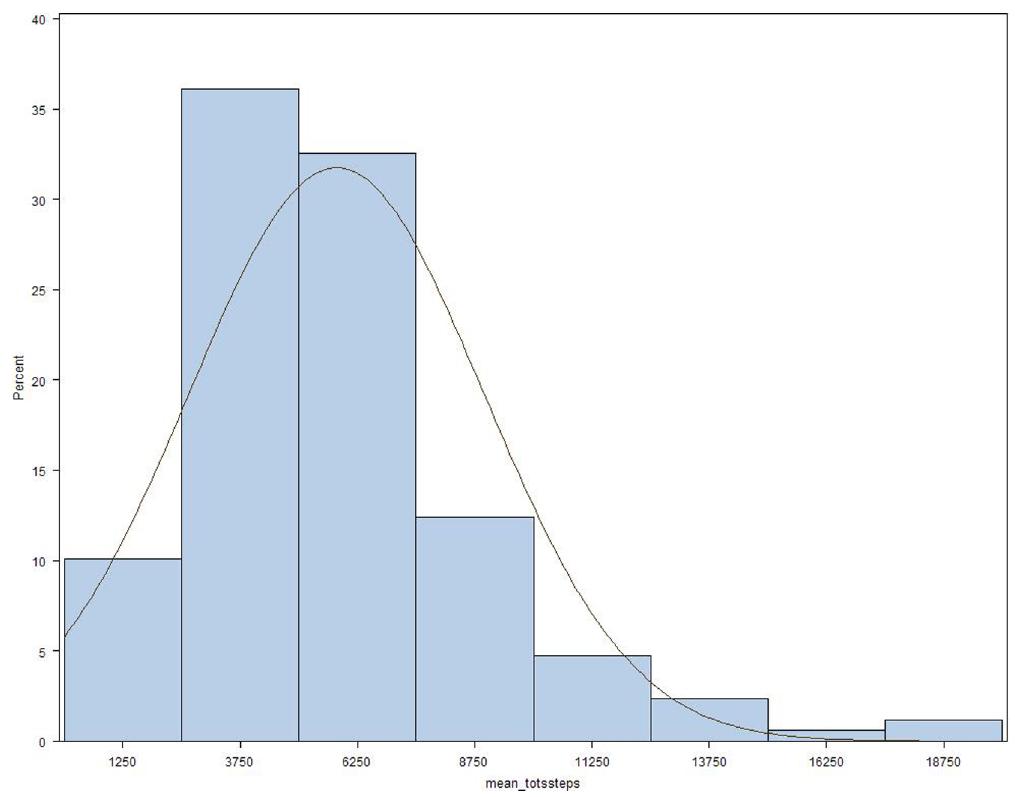
Figure 1. Distribution of mean daily step count. Median is 5,232 steps per day, N=169.